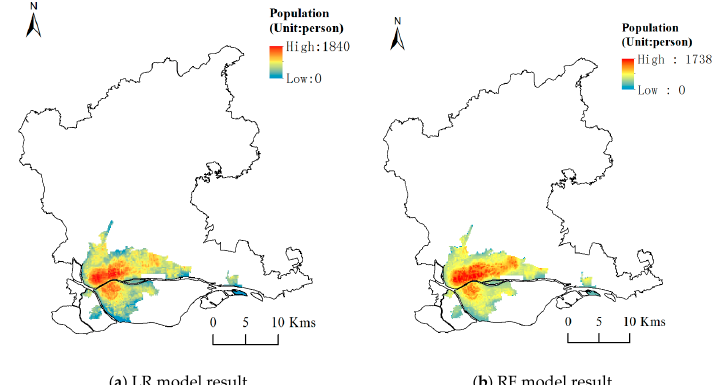
Figure 6. Population distribution maps in dense area. Table 5. Model accuracy in dense area.